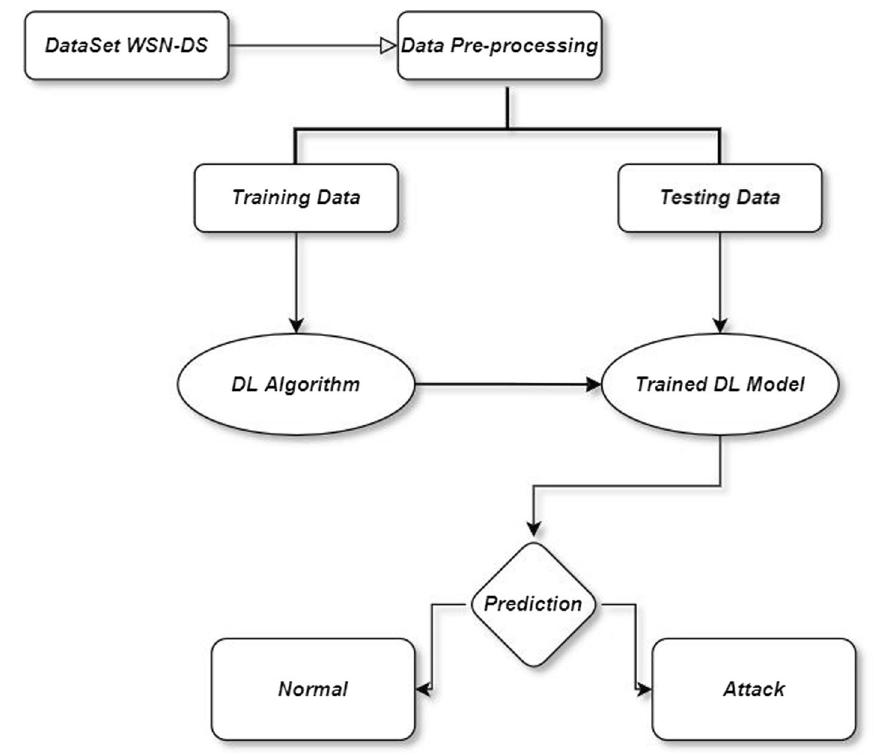
Fig. 6 Proposed methodology for detecting DoS attacks using DL